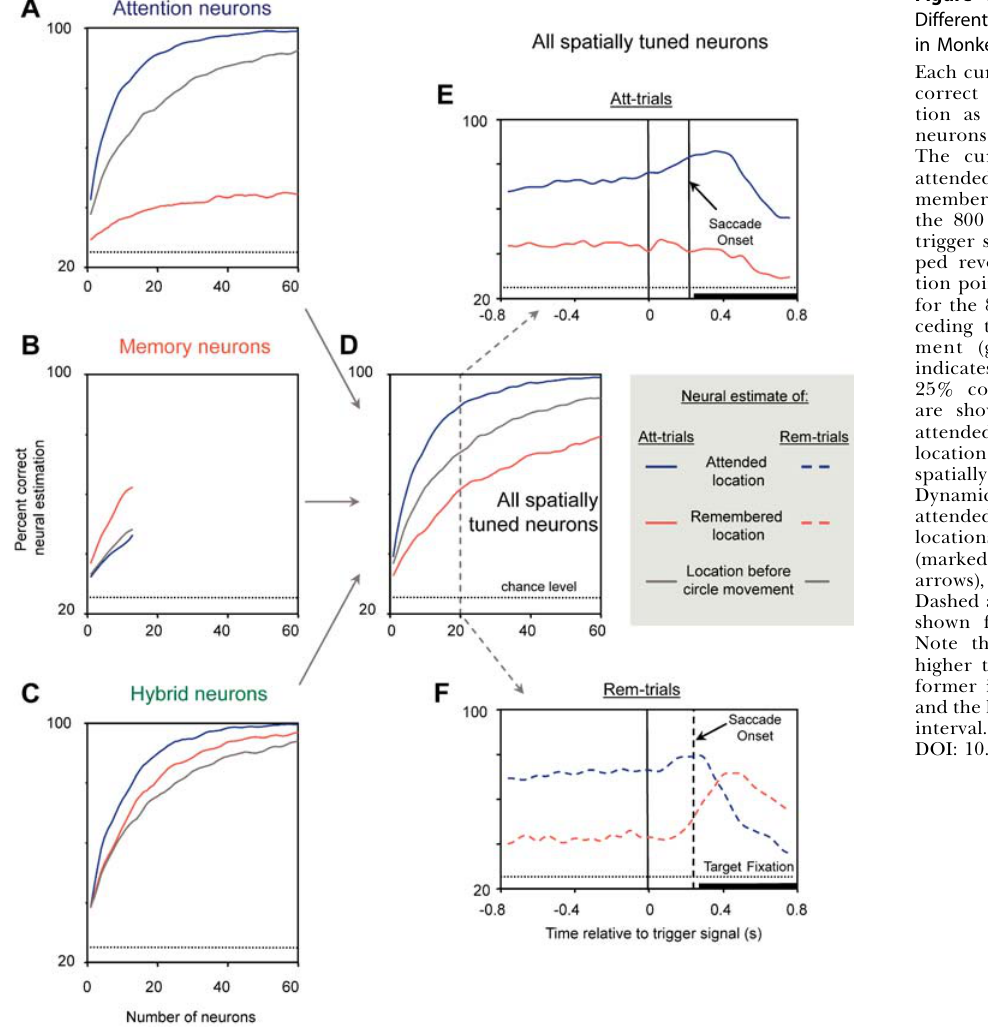
Figure 7. Neuron-Dropping Curves for Different Subpopulations of PFdl Neurons in Monkey 1 Each curve represents the percentage of correct single-trial estimations of loca- tion as a function of the number of neurons in the assembled populations. The curves show predictions of the attended locations (blue lines) or re- membered locations (red lines) during the 800 ms immediately preceding the trigger signal, after the circle had stop- ped revolving around the central fixa- tion point. Also shown is the estimation for the 800-ms period immediately pre- ceding the onset of the circle’s move- ment (gray lines). The dotted line indicates the chance level of estimation, 25% correct. Neuron-dropping curves are shown for neurons tuned to the attended location (A), the remembered location (B), both locations (C), and all spatially tuned neurons (D). (E) and (F) Dynamic changes in estimations of the attended (blue) and remembered (red) locations for 20 spatially tuned neurons (marked by the dashed gray line and arrows), using a 200-ms sliding window. Dashed and solid lines in (E) and (F) are shown for consistency with Figure 8. Note that the estimations in (D) are higher than in (E) and (F) because the former is based on an 800-ms interval, and the latter are based on only a 200-ms